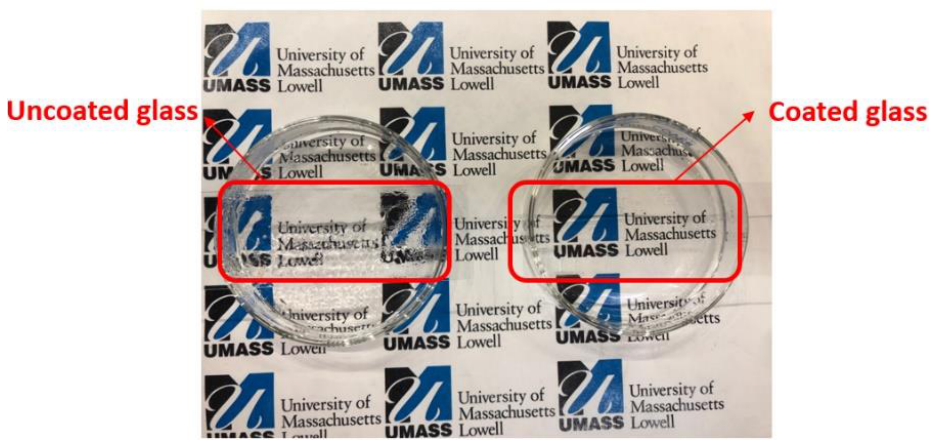
Figure 10. Bare glass ( left ) and SS6 coated glass ( right ) holding over a glass Petri dish containing hot water.